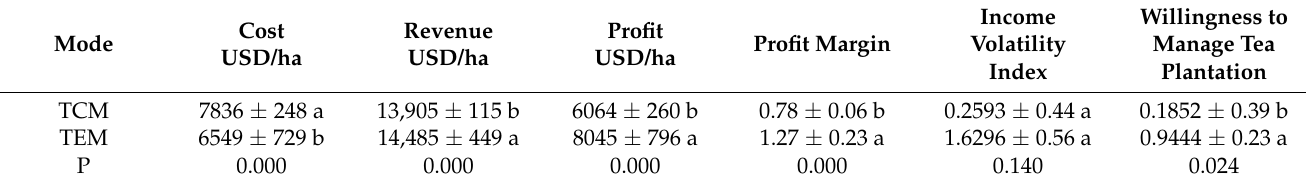
Table 5. The effects of management mode on the tea quality indices.